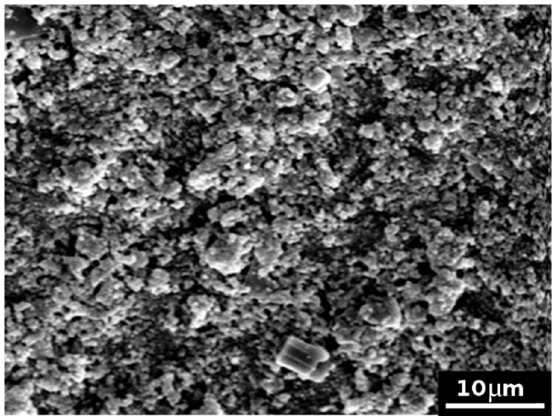
Figure 7. SEM picture (×2000) of model dentin treated with formulation 2 showing a completely covered surface layer.